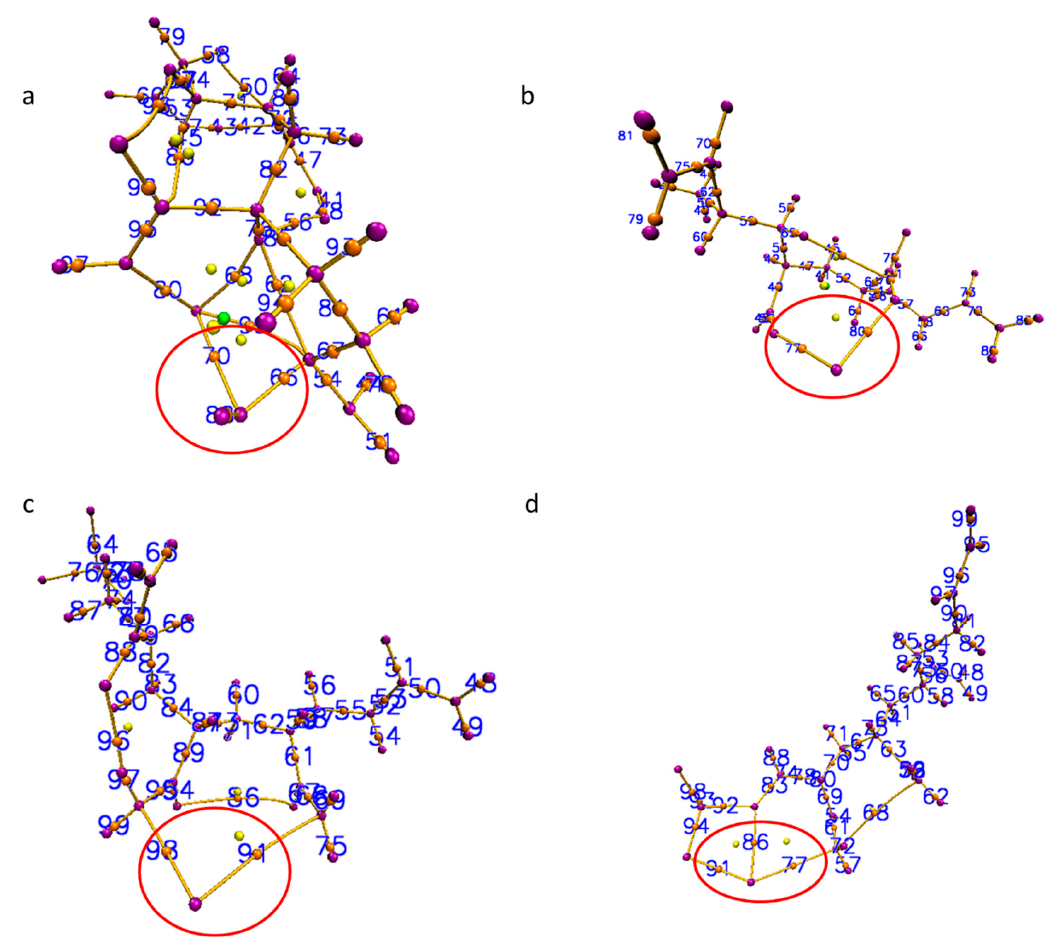
Figure 3. The bond critical points (BCP) of ( a ) Ca-PAM, ( b ) Ca-PAM_ hydrolyzed, ( c ) Ca-PAM_Silica1, and ( d ) Ca-PAM_Silica2. The BCP in red circles are those of concern that form bonds with Ca 2+ .